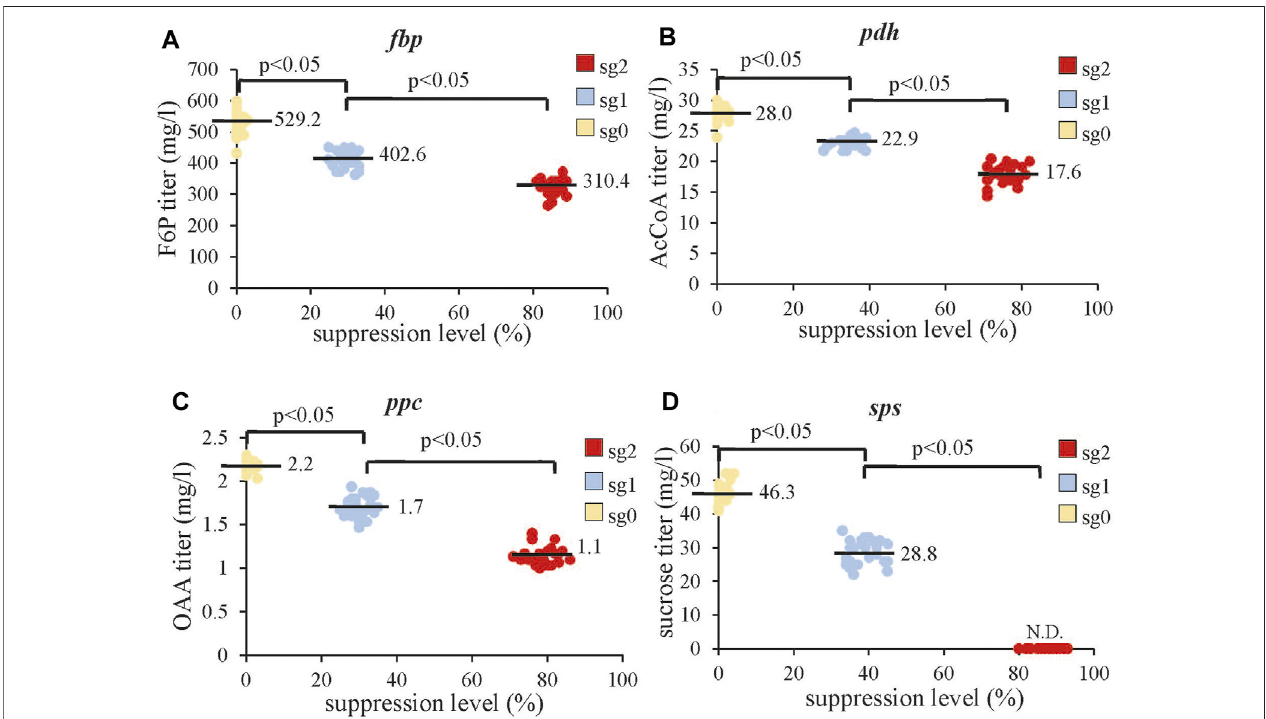
FIGURE 5 | Effectsof gene suppression on intracellular metabolite levels. (A) Effects of fbp suppression on F6P titer. (B) Effectsof pdh suppression on the AcCoA titer. (C) Effects of ppc suppression on the OAA titer. (D) Effects of sps suppression on sucrose. The data represent the mean ± SD of at least three independent experiments and werestatistically analyzed byone-way ANOVA. p < 0.05wasconsidered statistically signi fi cant. TheintracellularF6P, AcCoA, OAA,and sucrose for all 210 clones were analyzed by HPLC-MS. N.D., not